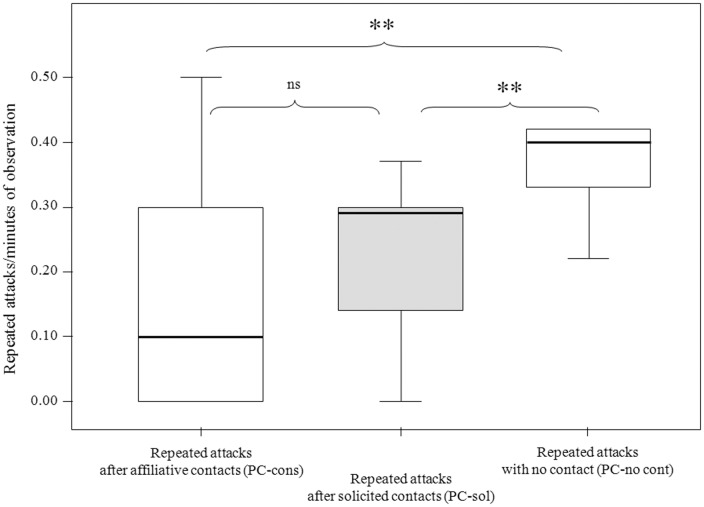
Repeated aggression in presence and absence of third party affiliation.Box plots of frequency of the repeated aggression towards victims after spontaneous affiliative contact (PC-cont), after solicited affiliative contact (PC-sol), and in absence of affiliative contacts (PC-no cont). Solid horizontal lines indicate medians; box length corresponds to the interquartile range; thin horizontal lines indicate the observed value range. Double asterisk and “ns” indicate highly significant (p<0.01, **) and non-significant results respectively. Results were obtained via Dunnett's post-hoc test.